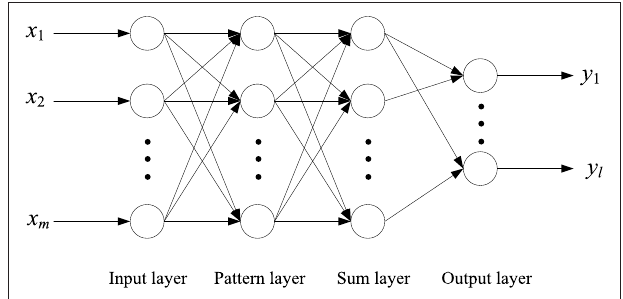
FIGURE 12 | The structure of the